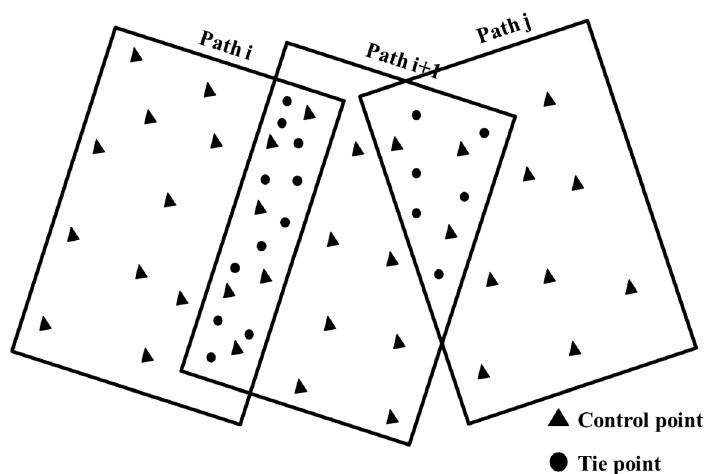
Figure 3. Velocity control points and tie points in multiple paths. Triangles and dots represent control points and tie points, respectively.